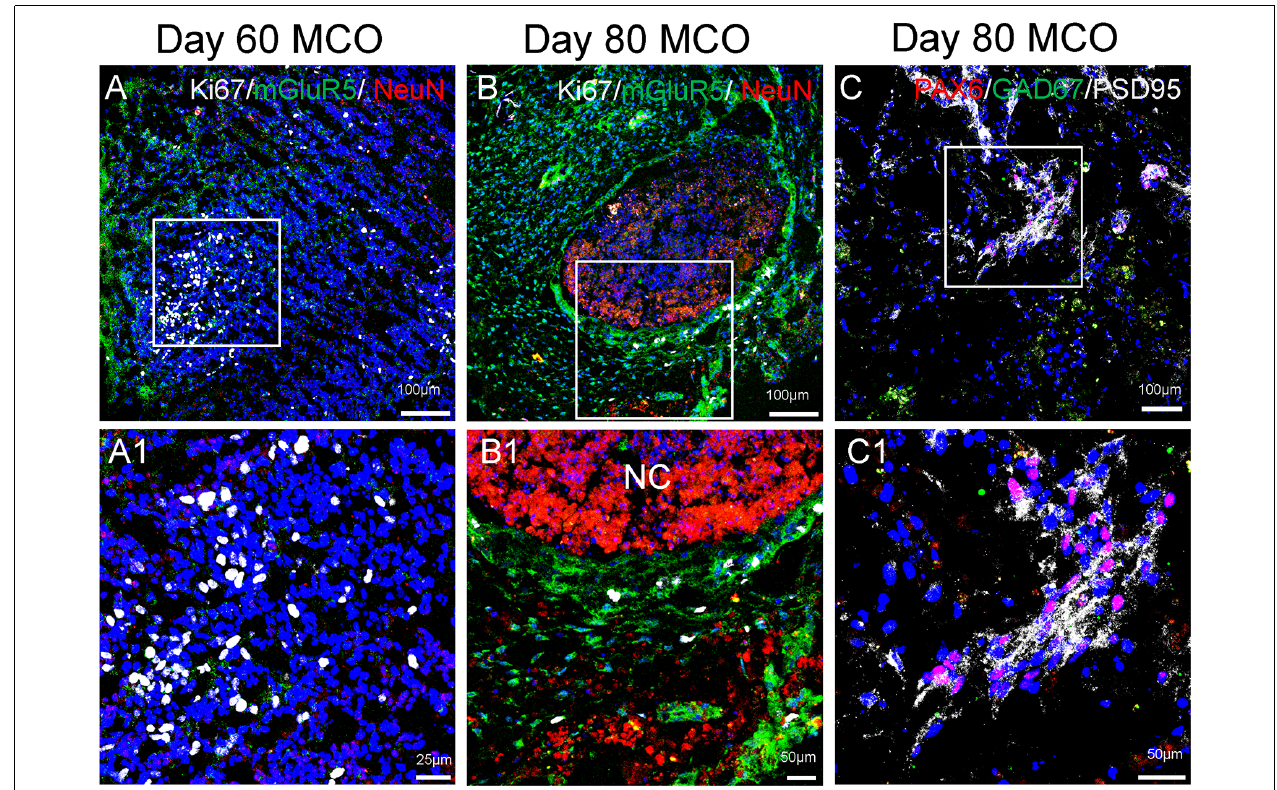
FIGURE 5 | Expression of mature neurons and clusters of NPCs in MCOs. Neuronal markers are present in MCOs at days 60 and 80, as detected by multi-labeled immunofluorescent confocal analysis. (A) At day 60, populations of proliferating cells (Ki67 + ) and mature neurons (NeuN + ) can be detected. Small clusters of postsynaptic excitatory receptors are detectable as well (mGluR5 + ). (B) At day 80, proliferating cells and mature neurons are still detectable, with mGluR5 expression appearing more pronounced and Ki67 expression appearing decreased, suggesting a trend towards neuronal differentiation vs. neural cell proliferation. (C) NPCs (PAX6 + ) are expressed in day 80 MCOs, as well as inhibitory GABAergic neurons (GAD67 + ) and postsynaptic proteins (PSD95 + ). Hoechst was used as a nuclear marker. NC, necrotic center. Panels (A1) , (B1) , and (C1) represent the digital zoom-in images from the corresponding